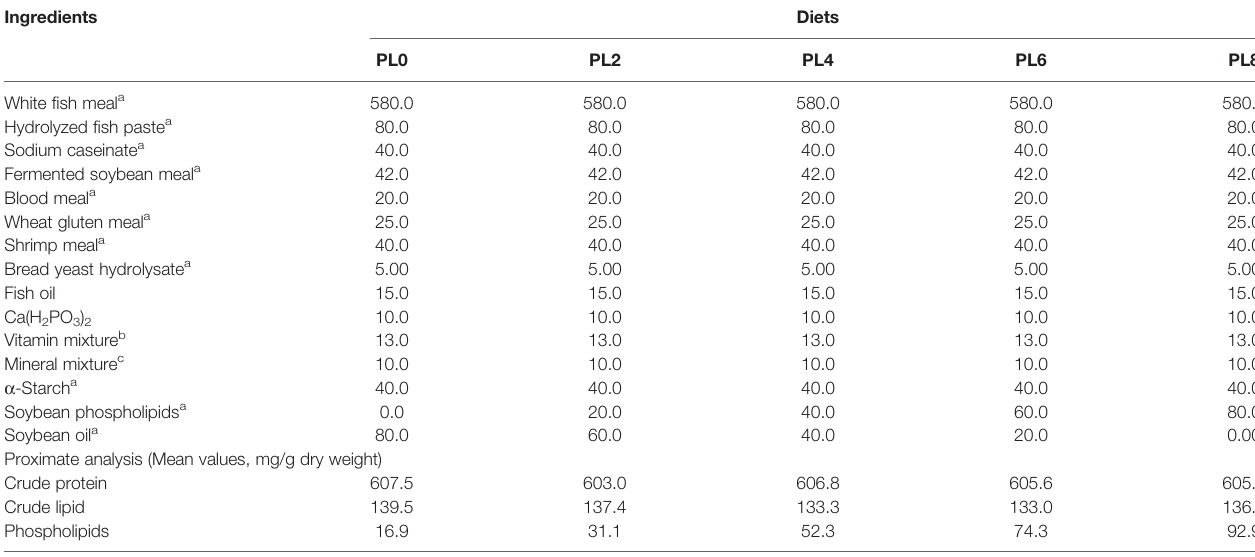
TABLE 1 | Formulation and proximate composition of experimental diets (mg/g dry matter).